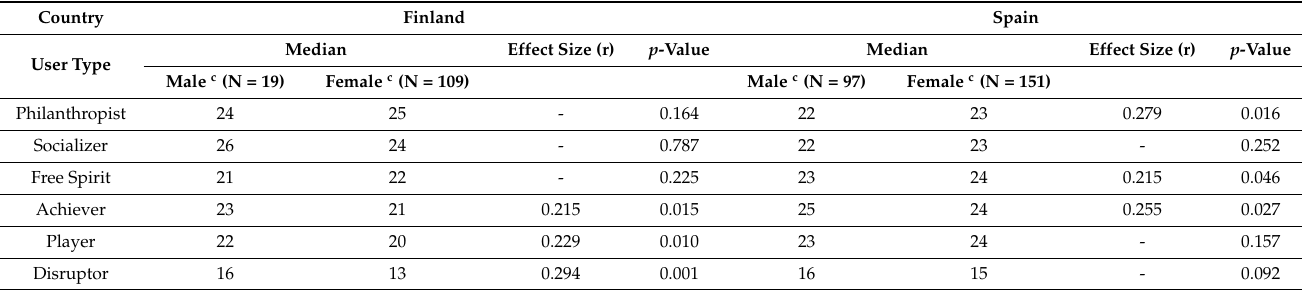
Table 3. Mann–Whitney U-test for distribution of user types between